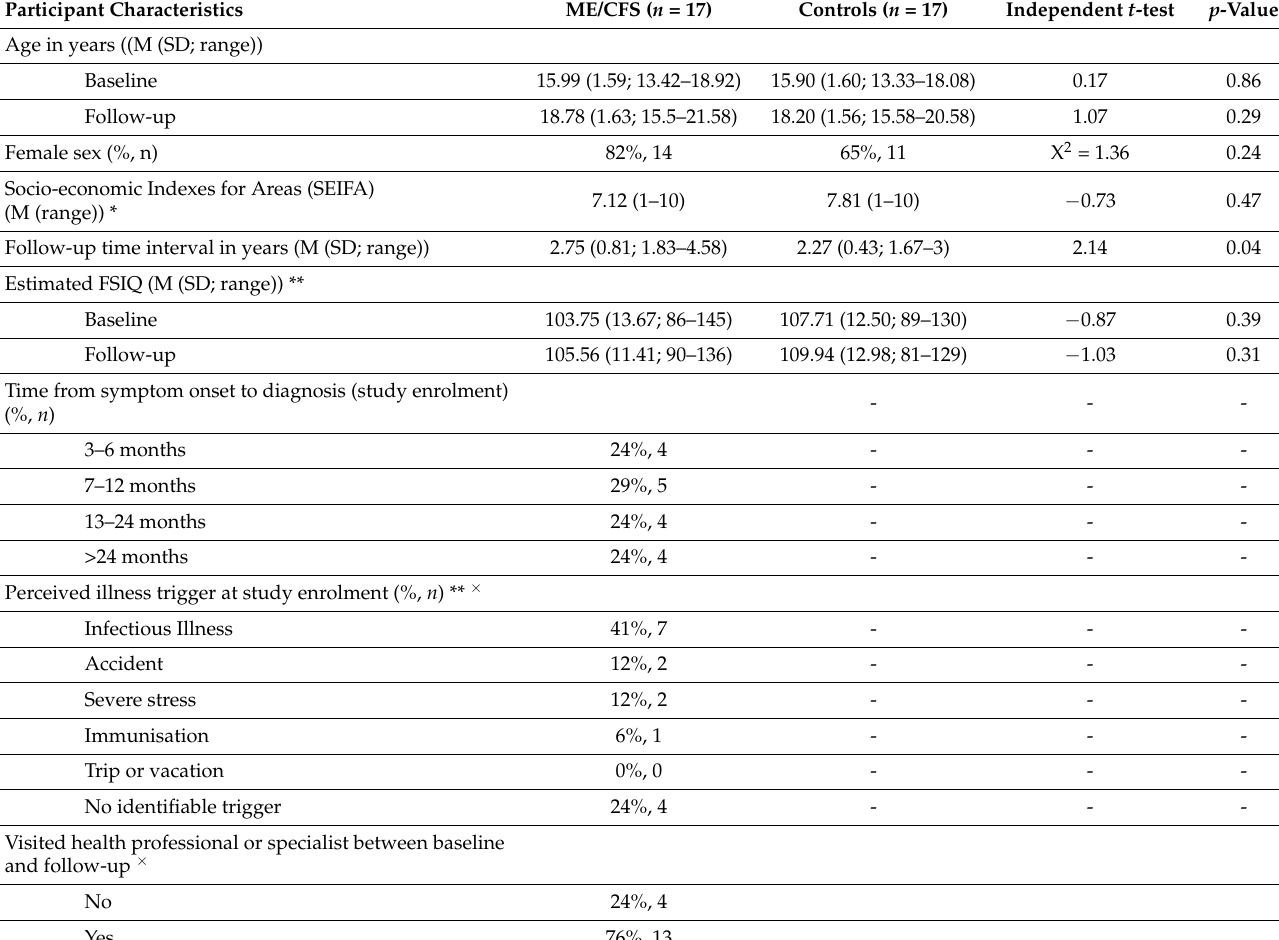
Table 2. Participant characteristics at baseline and